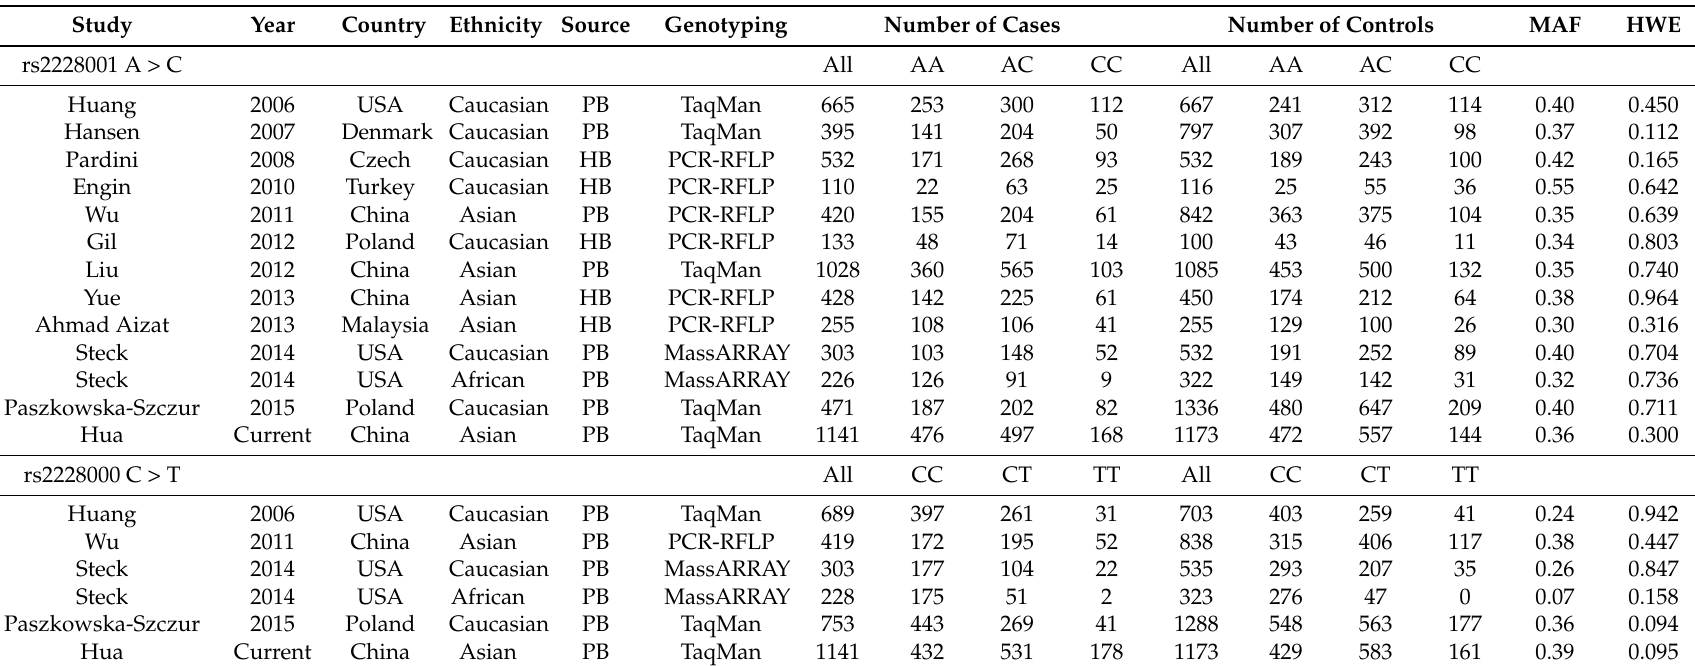
Table 4. Characteristics of available studies included in the current